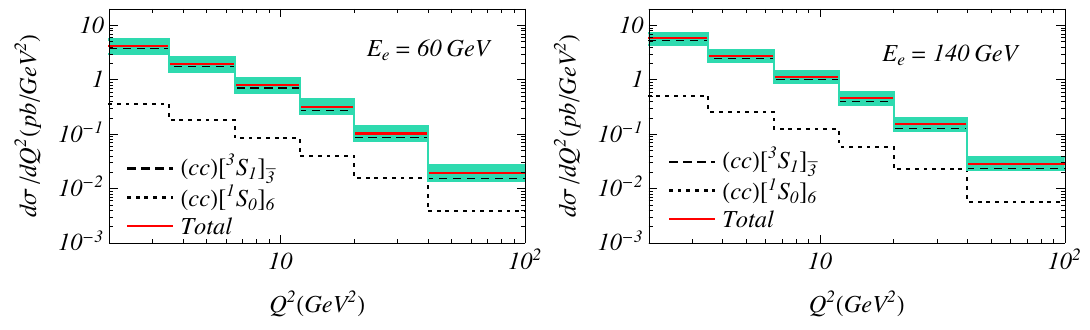
Figure 3 . The di(cid:11)erential cross sections as a function of Q 2 under the kinematic cuts in equa- tion (3.1), corresponding to E e = 60 GeV and E e = 140 GeV, respectively. \ Total " denotes the sum of the contributions via ( cc )[ 3 S 1 ] (cid:22) and ( cc )[ 1 S 0 ] 6 . The band is caused by the variation of (cid:22) r (= (cid:22) f ) 3 from 0 : 5 (cid:22) 0 to 2 (cid:22) 0